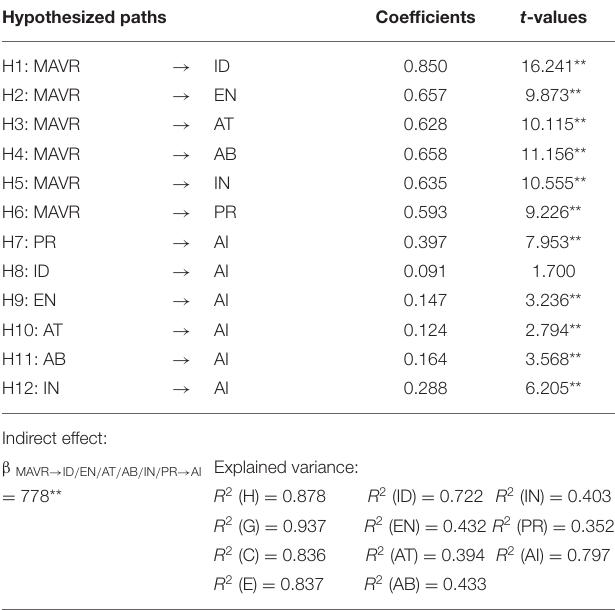
TABLE 3 | The structural model estimation. Hypothesized paths